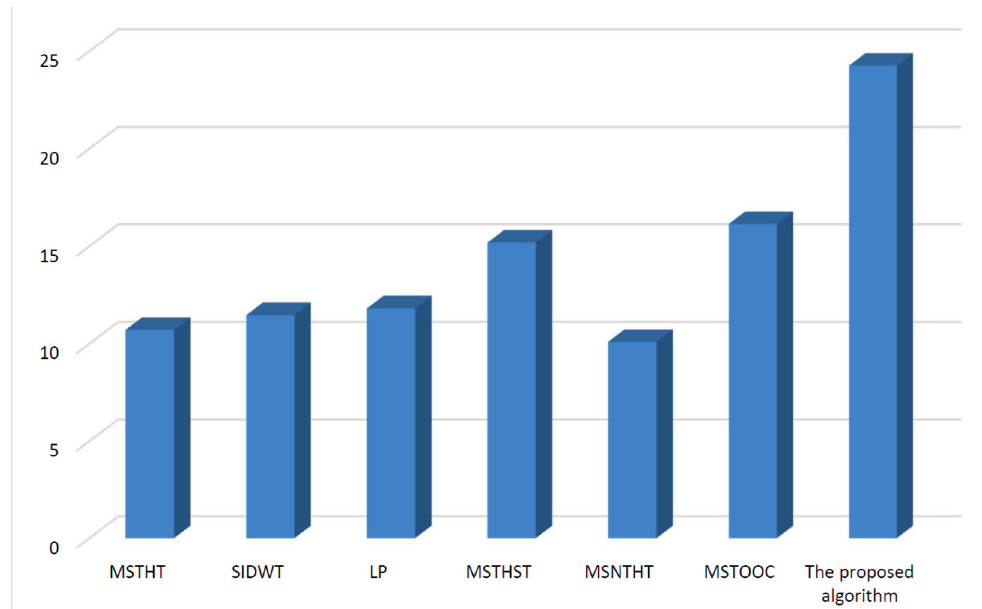
Figure 5. Quantitative comparison using measure spatial